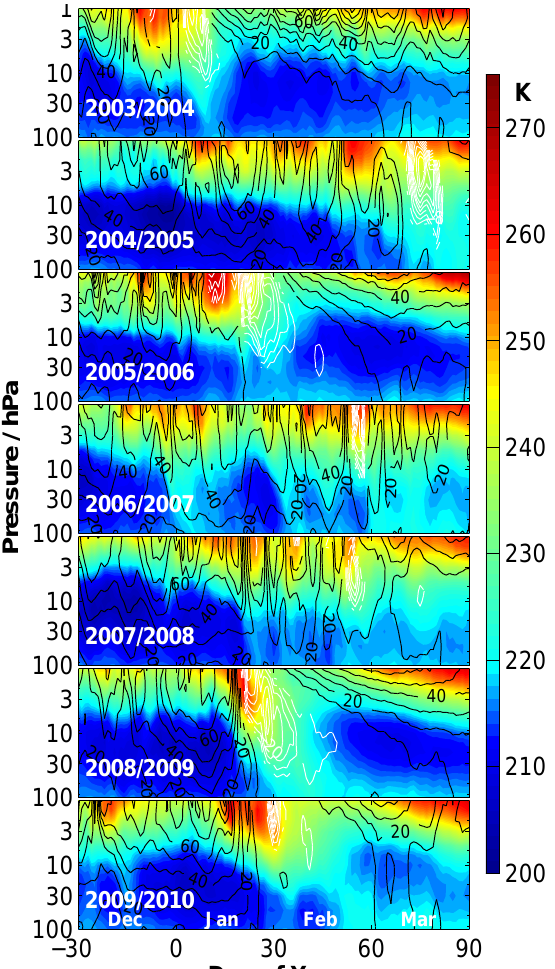
Fig. 2. Temporal evolution of the vertical distribution of zonal-mean temperatures (color contours) in the ECMWF operational analysis for the Arctic winters 2003/04–2009/10. The overlaid white con- tours illustrate the position and propagation of the zonal-mean east- erlies and the black overlaid contours are the zonal-mean westerlies.